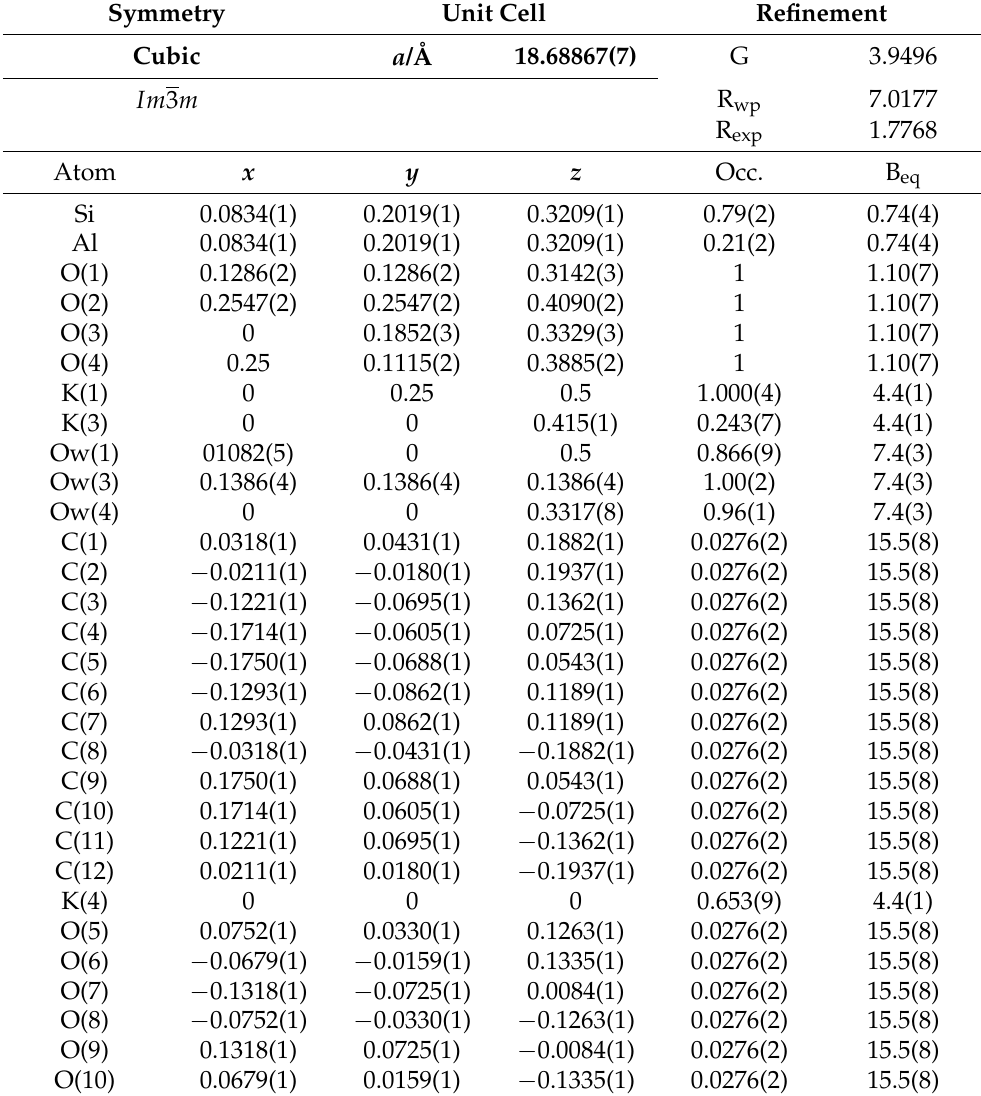
Table 6. Final refined unit cell parameters and crystallographic sites for the filled zeolite ZK-5 sample. ‘Occ.’ refers to the fractional occupancy of the relevant crystallographic site. Error in